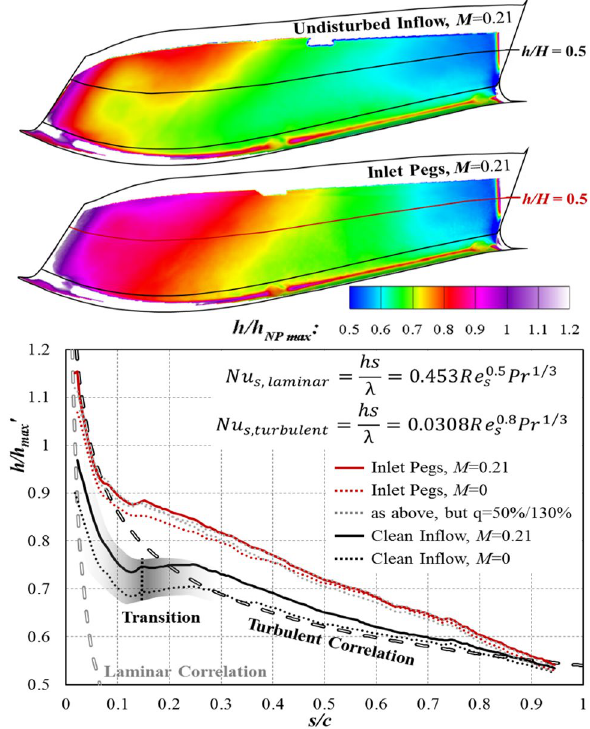
Fig. 11 Heat transfer coefficient on the struts, chordwise variation of h at strut midspan for all investigated conditions